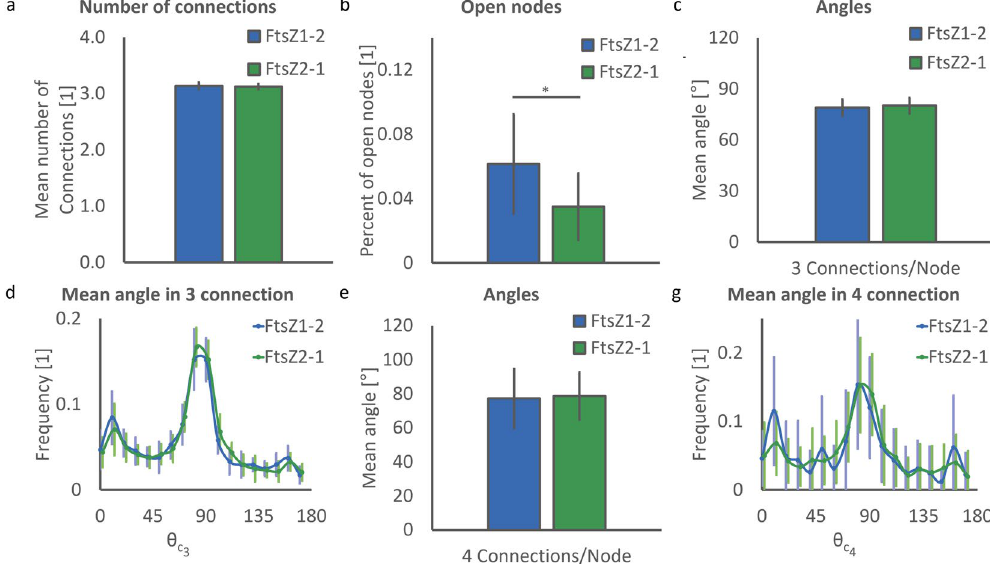
Figure 7. Evaluation of connections. ( a ) Mean number of connections per network. n = 12468 and 7905 connections for FtsZ1-2 and FtsZ2-1, respectively. ( b ) Percentage of open nodes. n = 237 and 87 open nodes for FtsZ1-2 and FtsZ2-1, respectively. ( c ) Mean values of angles between segments in nodes with three connections. ( d ) Normalized distribution of mean angles in nodes with three connections. ( e ) Mean values of angles between segments in nodes with four connections. ( g ) Normalized distribution of mean angles in nodes with four connections. ( c – g ) n = 6648 and 5163 for 3-per-node connections and 966 and 691 for 4-per-node connections for FtsZ1-2 and FtsZ2-1, respectively. ( a – g ) A total of 40 networks (20 networks for each isoform) were used for each statistical analysis. Each network corresponds to a distinct chloroplast. For each plot FtsZ1-2 and FtsZ2-1 are represented in blue and green, respectively and data is shown as mean ± standard deviation. In the bar plots * indicates significant difference between